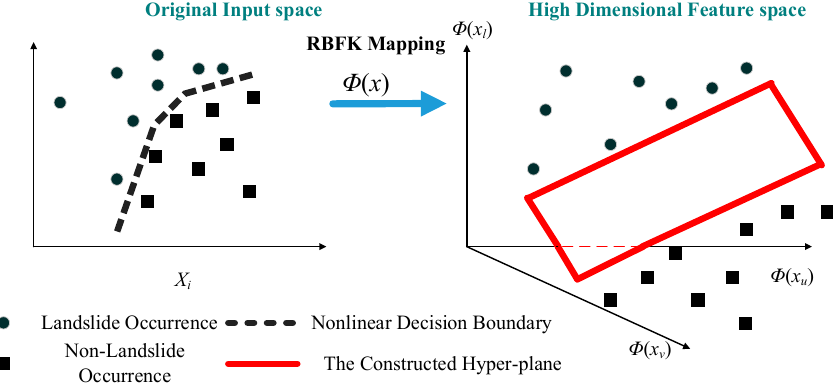
Figure 5. Illustration of the SVM based data classification (RBFK: Radial Basis Function Kernel).